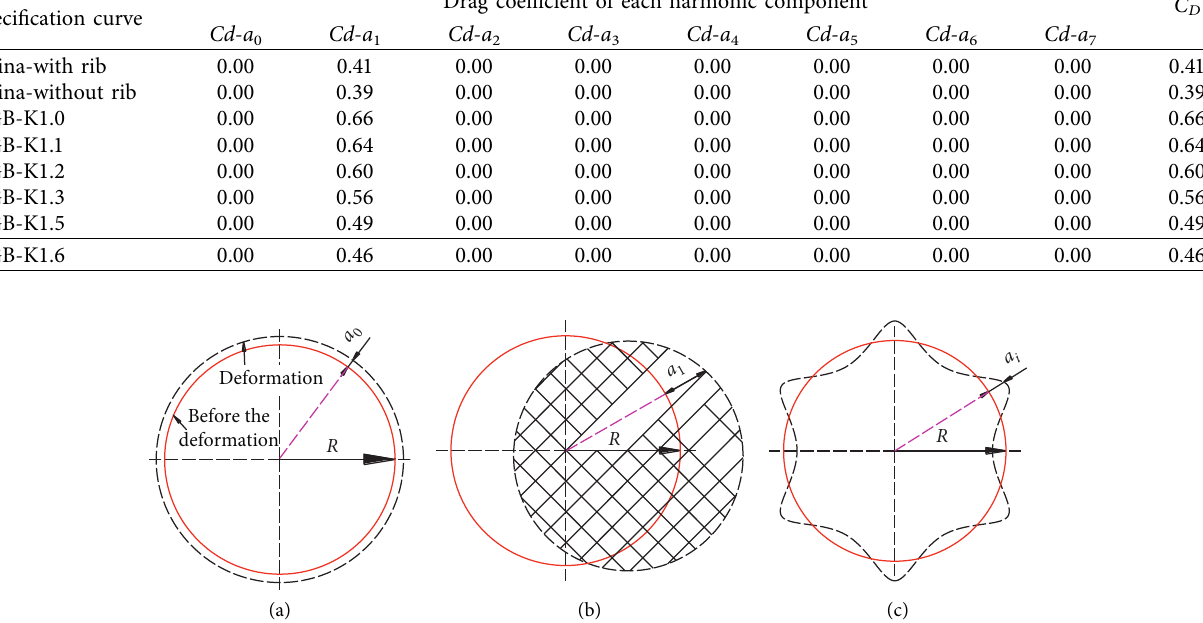
� 0 . (b) a 1 . (c) a i ( i